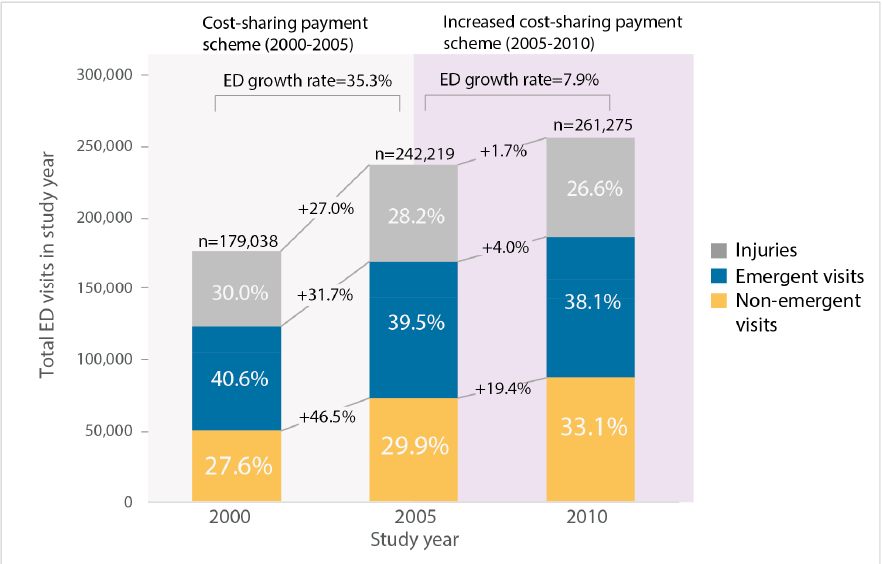
Figure 1. Annual emergency department (ED) visit, growth rates, and proportions of ED visit classification by study year from three representative study cohorts (LHID2000, LHID2005, LHID2010) in Taiwan. ( n = 1,000,000 for each cohort). Growth rates of ED visits are expressed in percentages and overlaid on lines between study years. Background shading in different colors represents different cost-sharing payment schemes. The sum of the percentages is less than 100 because conditions such as psychosis and alcohol or drug problem (<2%) are not shown in the figure.